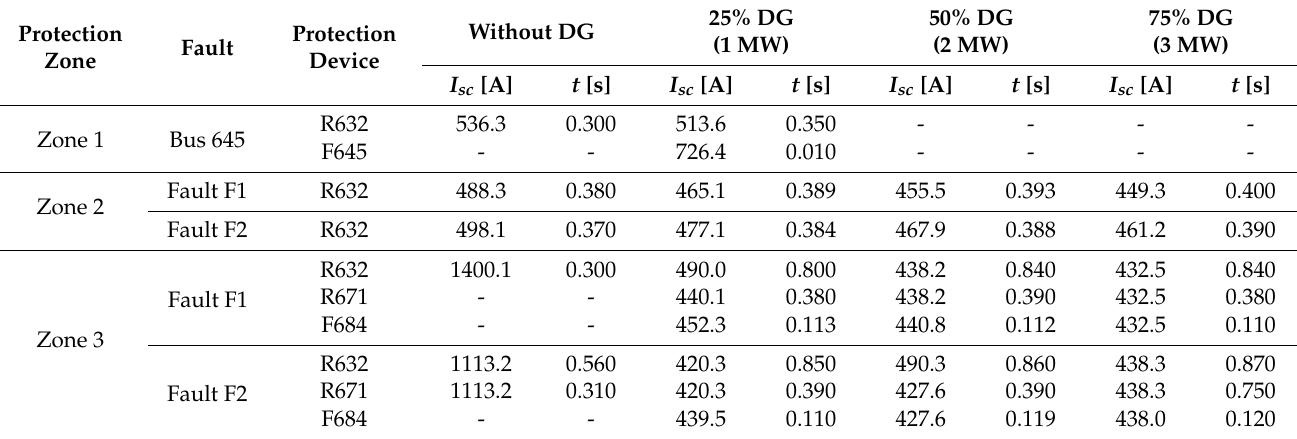
Figure 5. Triggering time, t , of protection relay R632 in Protection Zone 1 (see Figures 2 and 3), in relation to the power supply from DG. The currents detected by the relay when triggering were added to the graph in each case. Table 2. Relay and fuse currents, I , and triggering times, t , in the protection devices from the defined Protection Zones 1, 2, and 3 (see Figure 2, Figure 3, Figure 6, and Figure 10), in relation to the power supplied by the DG (1, 2, and 3 MW, representing 25%, 50%, and 75% of the photovoltaic installed